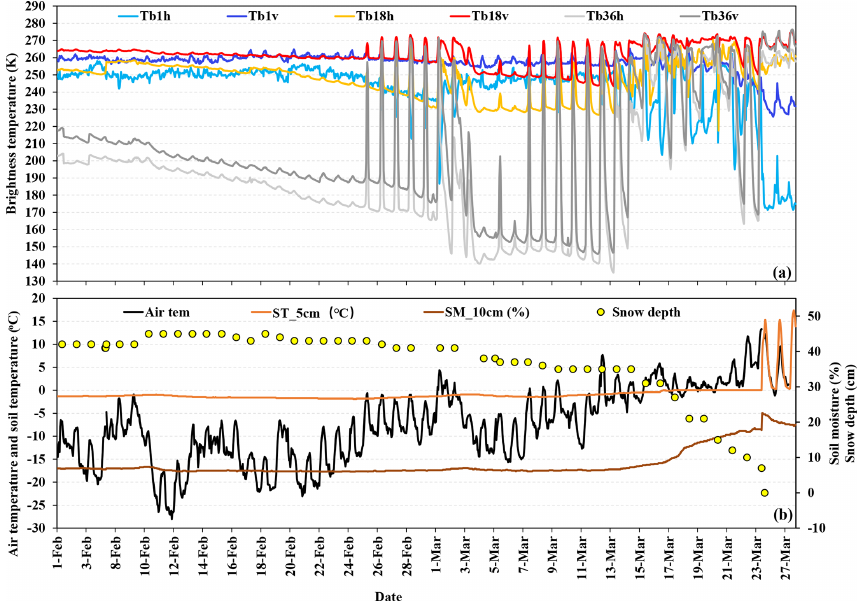
Figure 13. Hourly variation in (a) Tb1h, Tb18h, Tb36h, Tb1v, Tb18v, and Tb36v, and (b) air temperature, soil moisture at 10cm, soil temperature at 5cm, and daily variation in snow depth, from 1 February to 28 March